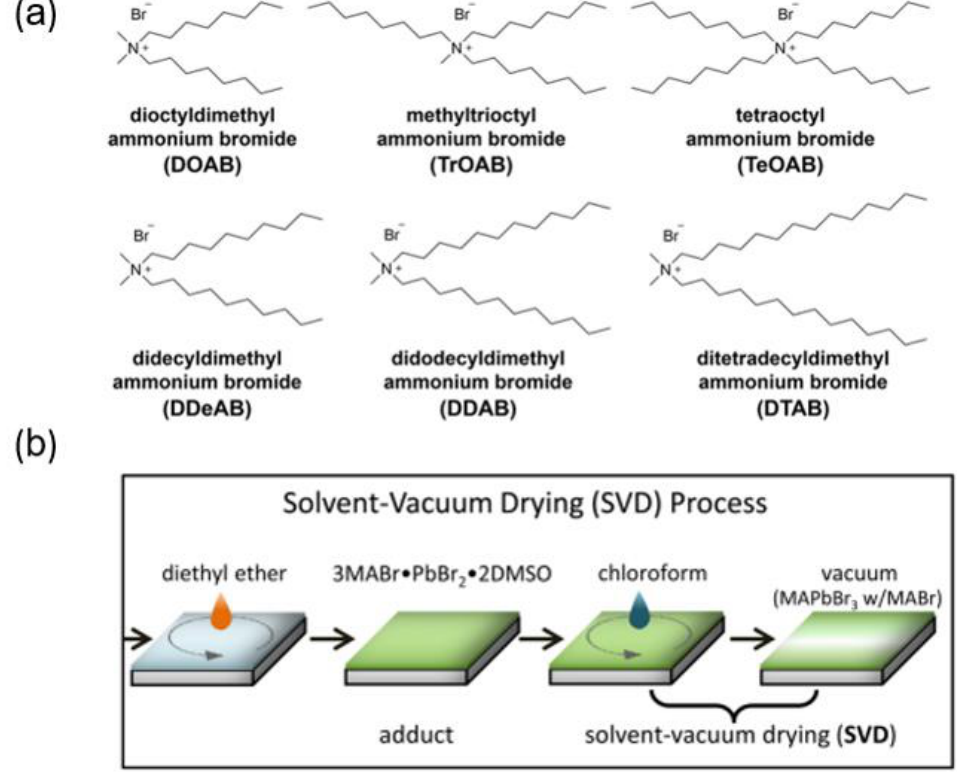
Figure 5. ( a ) Chemical structures of various QAB ligand materials with different bulkiness and